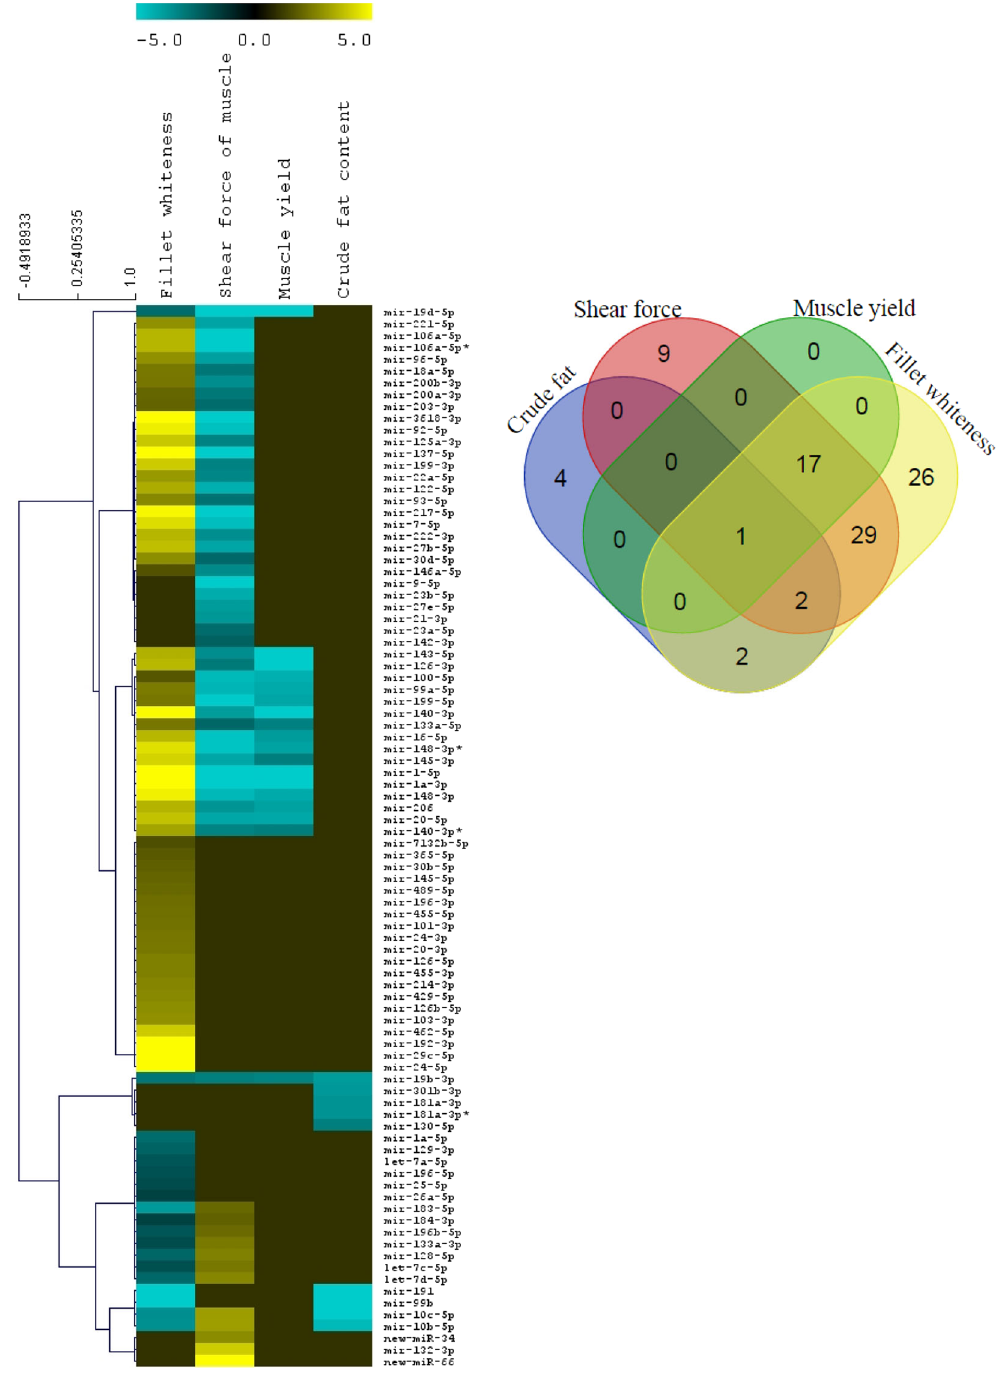
Figure 2. Heat map of fold change of differentially expressed (DE) microRNAs between high vs low ranked families of various traits (left) and Venn-diagram showing shared DE microRNAs between different traits (right). In heat map, dark green and yellow colors indicate downregulation and upregulation respectively in high ranked family compared to low ranked family. Dark color indicates no differential expression of microRNAs. Note that the value of color limit ( − 5 to 5) does not reflect true fold change as values of fold change were transformed (log2) and color scale was adjusted to make the heat map more visible. True fold change is given in Supplementary Dataset